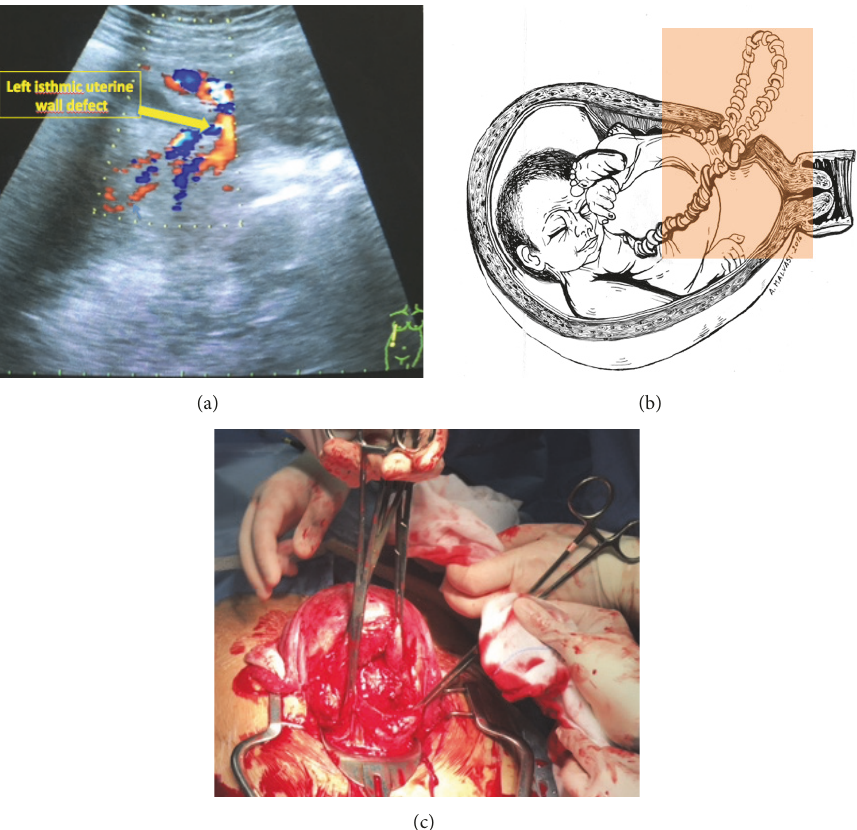
Figure 1: (a) 2D transabdominal US and color Doppler findings: a loop of umbilical cord was noted outside the uterus and running through the left isthmic uterine wall focal defect. (b) Graphic depiction of the loop of umbilical cord herniated outside the uterus through the left isthmic focal defect. (c) Macroscopic appearance of the uterine rupture at surgery.